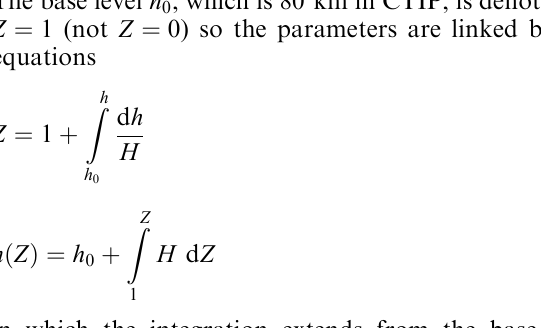
Table 1. Pressure-levels, real heights and temperatures for typical midlatitude conditions at F Pressure-level